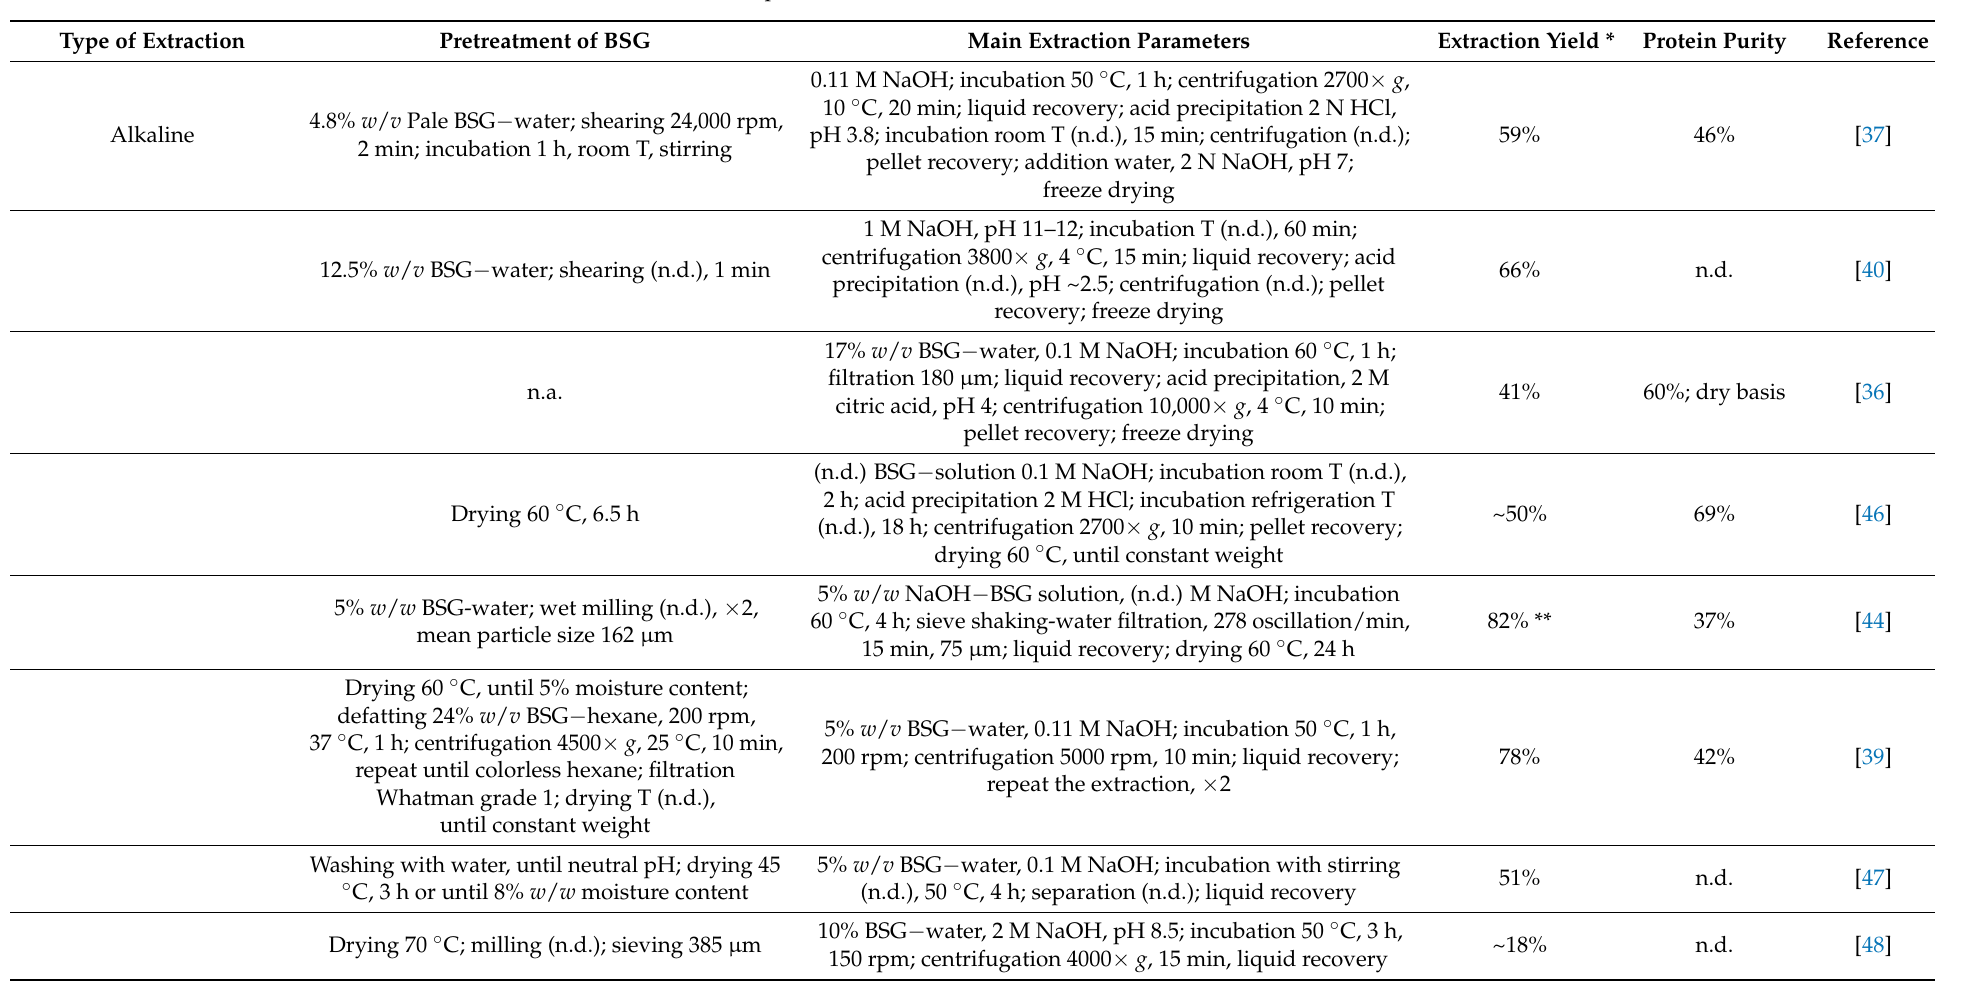
Table 3. Methods and conditions to extract proteins from